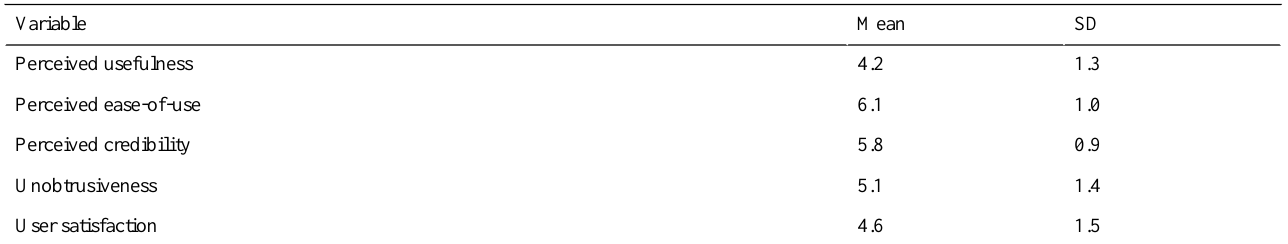
Table 4. User acceptance of Mamma